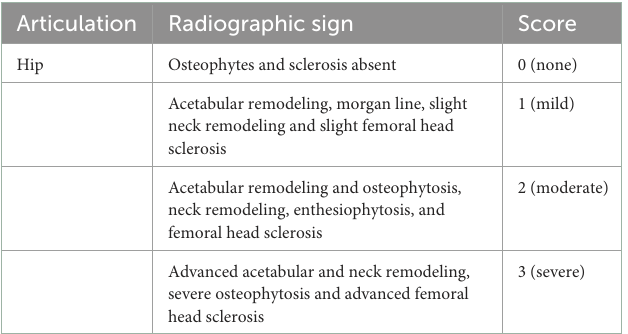
TABLE 2 Scoring system for the radiographic evidence of osteoarthritis